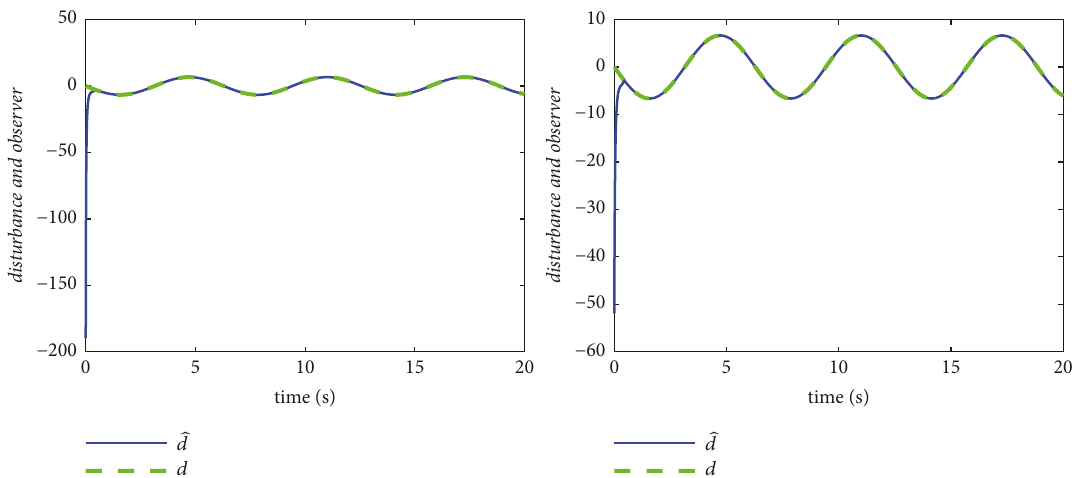
Figure 6: The FTSMDO and disturbance in the entire simulation